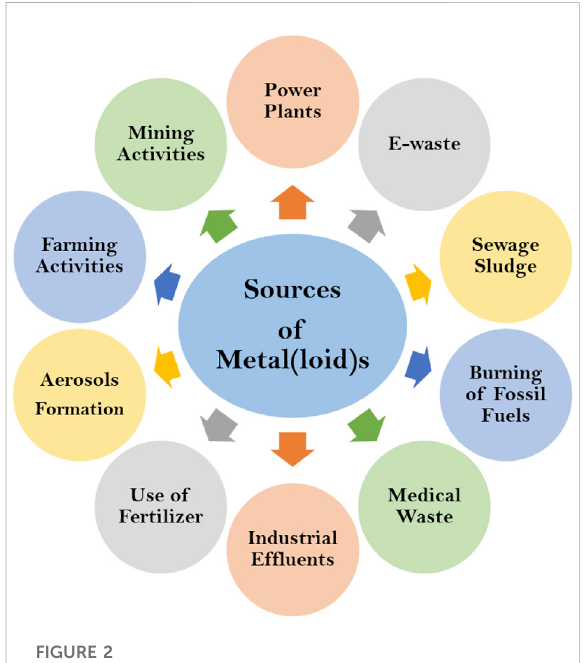
FIGURE 2 Various sources of Metal(loid)s in the